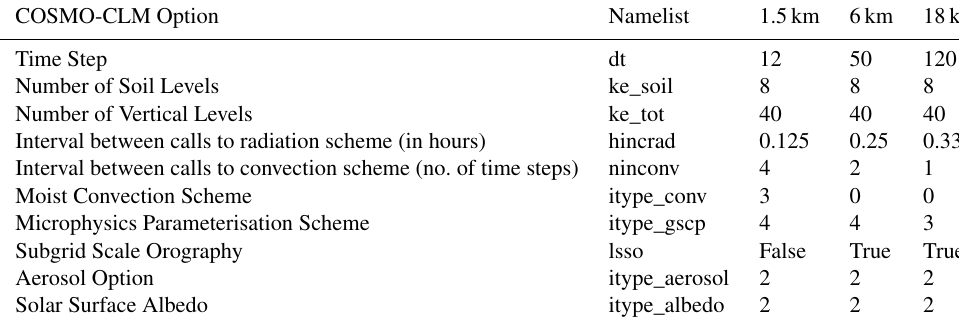
Interval between calls to radiation scheme (in hours) Interval between calls to convection scheme (no. of time steps) Moist Convection Scheme